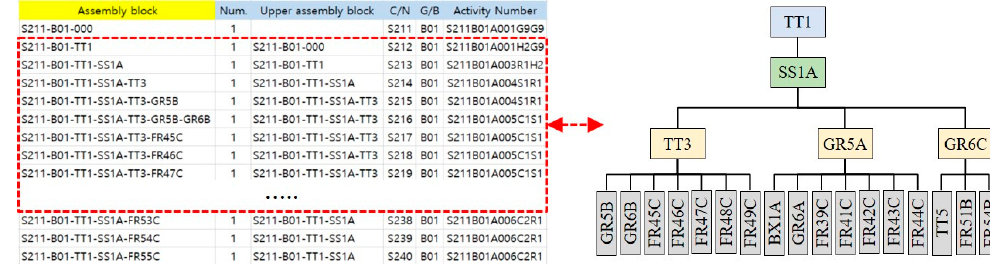
Figure 3. Typical structure information of large assembly blocks (Left: hierarchy structure information of large assembly blocks. Right: work breakdown structure of TT1 blocks based on the bill of materials (BOM)).